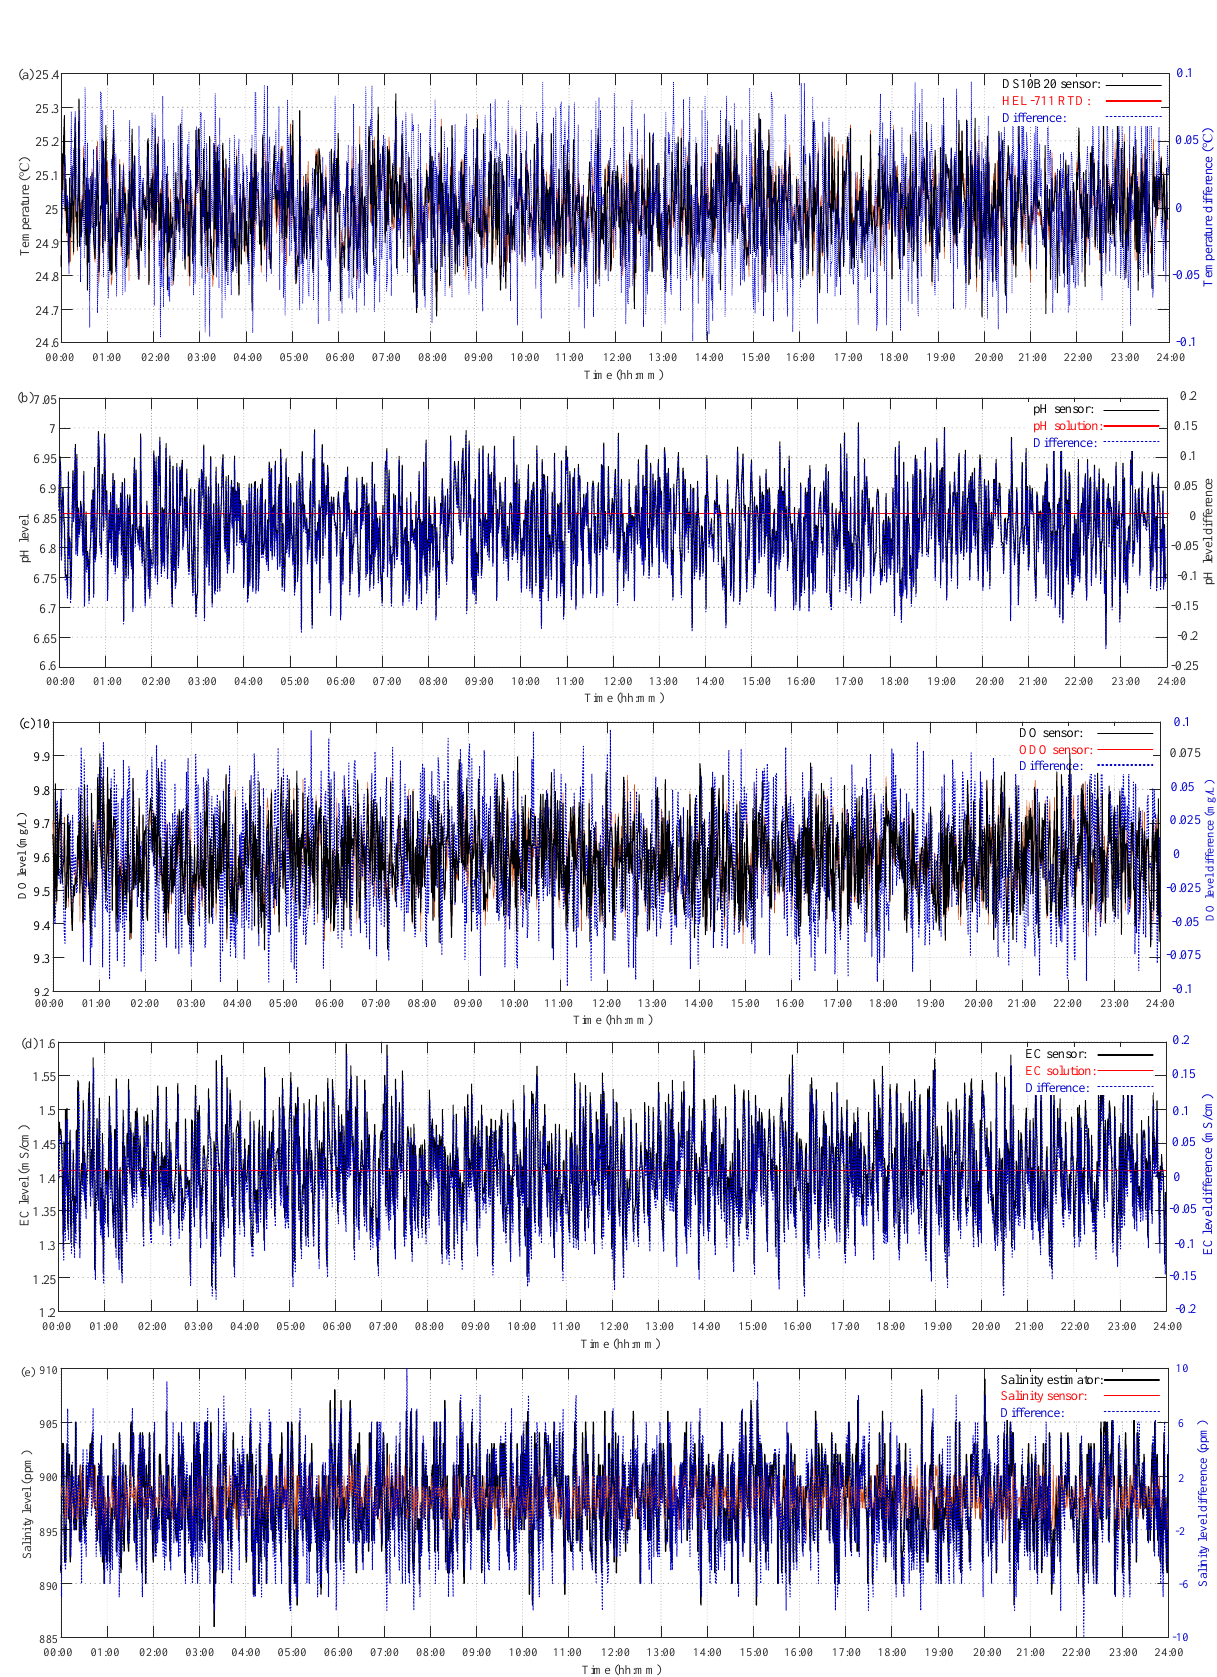
Figure 9. The 24 h measurement results of post-calibration process: ( a ) temperature; ( b ) pH level; ( c ) DO level; ( d ) EC level; and ( e ) salinity level.